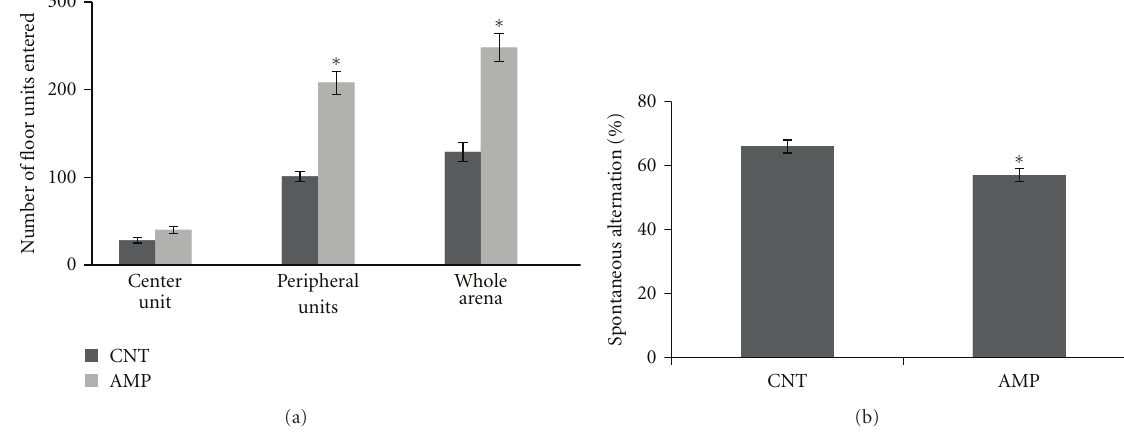
Figure 1: AMP-induced behavioral changes. Mice were administered intraperitoneally with 1.0mg/kg d-AMP once a day for 21 days or a same volume of saline during the same period. The spatial working memory of mice was measured two days after the last injection and the locomotion five days. Data were expressed as means ± SEM. Comparisons were made between CNT and AMP groups. ∗ P < 0 . 05. For open-field test, all 12 mice in the AMP group entered the peripheral units more often than the average of CNT group. For Y-maze test, of 12 subjects in the AMP group, two mice showed spontaneous alternations (68 and 71%) above the average of CNT group